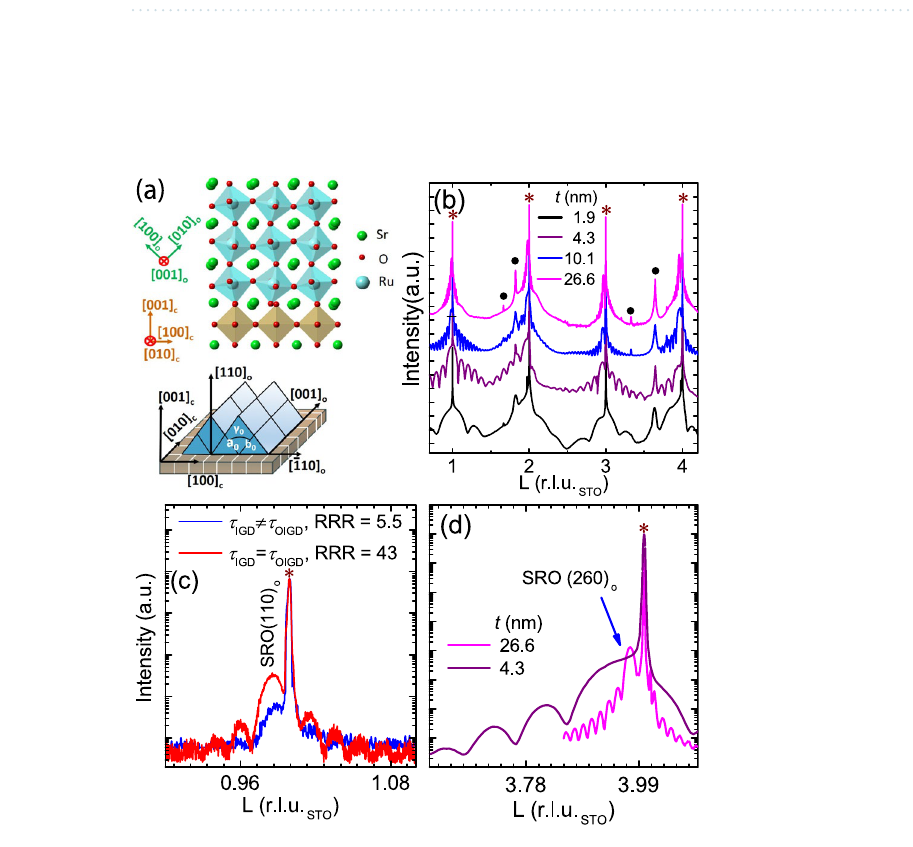
Figure 4. Structural investigation of SRO films on STO using XRD. ( a ) displays the tilting of the RuO 6 octahedra of an orthorhombic SRO film on a cubic STO. ( b ) CTR of the SRO( t )/STO films. The presence of fringes around the Bragg peaks revealed the excellent crystalline quality of the SRO films and sharp interfaces. The peaks marked by solid spheres are attributed to the random Ru clusters present on the film surface. ( c ) Radial scan along surface normal of t ≈ 21.5 nm films grown under τ IGD = τ OIGD and τ IGD = τ OIGD . The pronounced Laue oscillations appeared only for the film grown with τ IGD = τ OIGD . ( d ) L-scan of the off-normal SRO (260) o reflection for SRO films with t ≈ 26.6 and 4.3 nm. Pronounced fringes with a period nearly the same as that of corresponding specular rod reveal the excellent lateral crystalline quality of the SRO